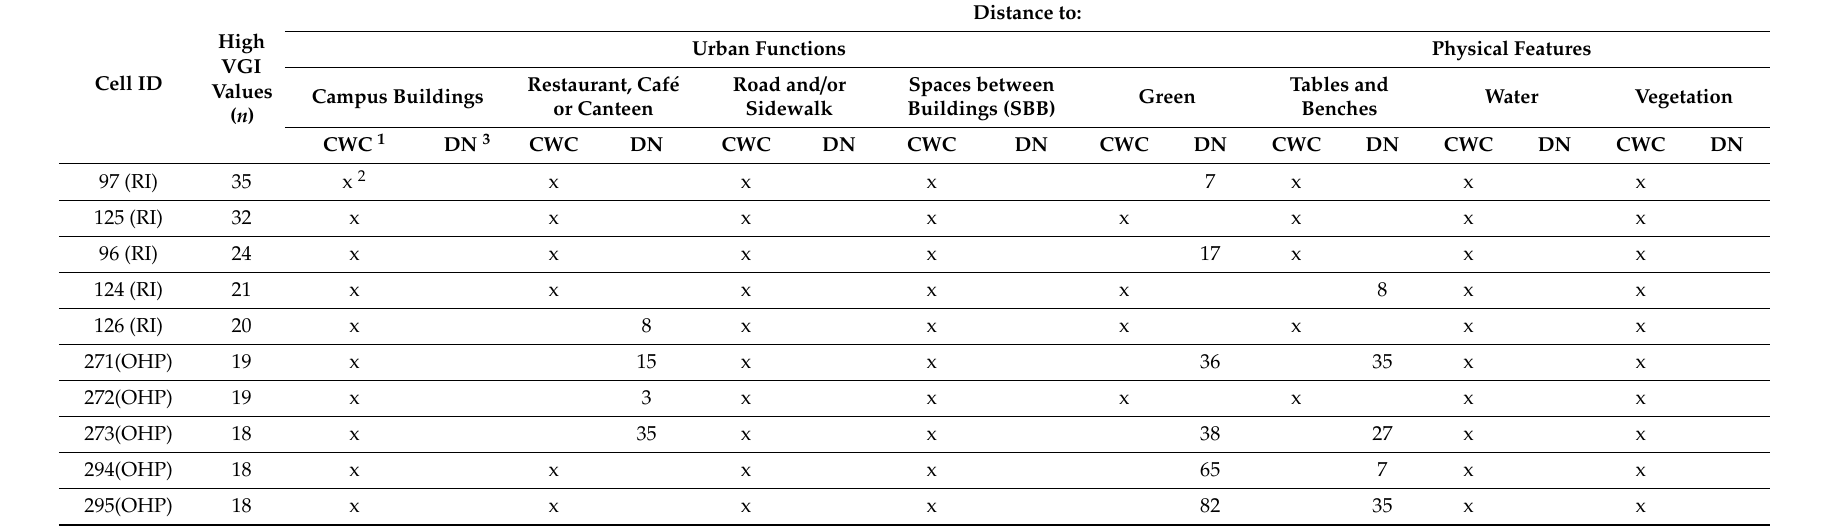
Table 6. Distance between VGI data and built-environment features. Amsterdam inner-city